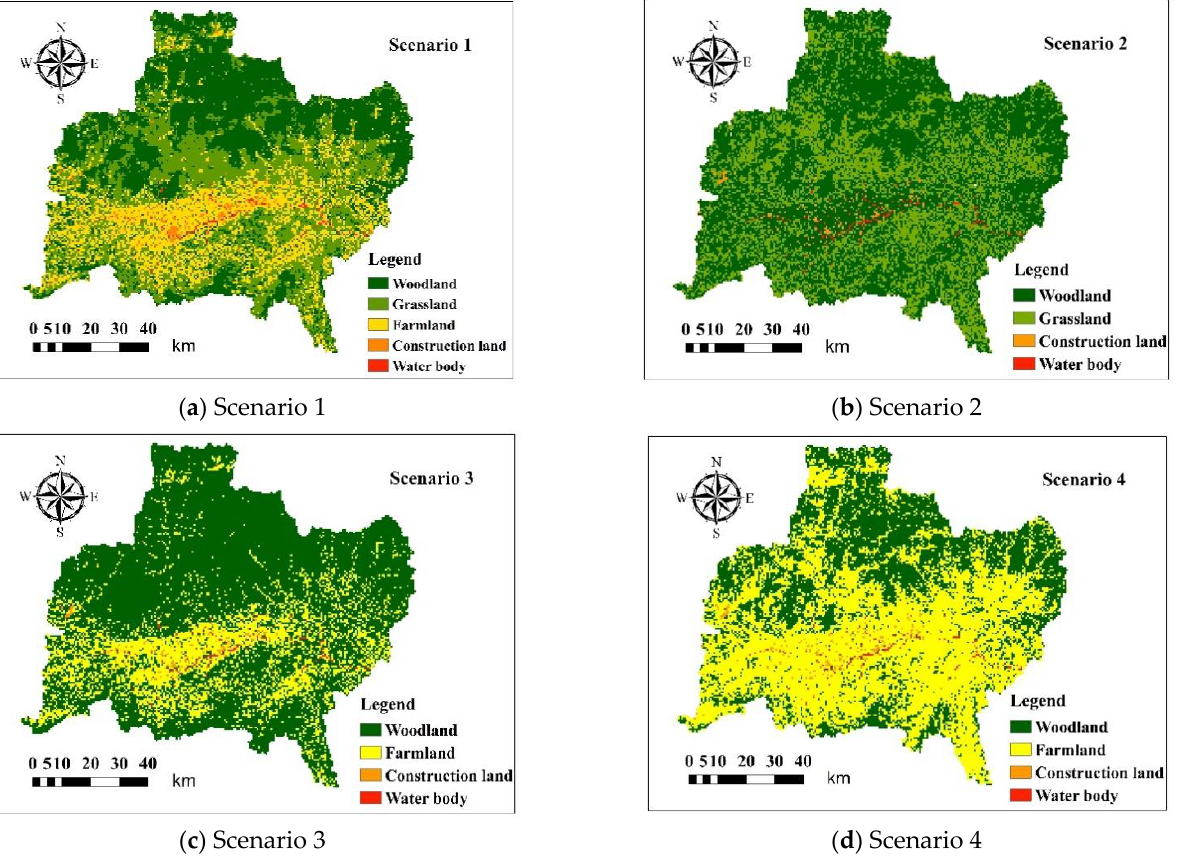
Figure 5. Spatial change map of land use under each scenario. Table 5. Area of land-use type in each scenario.